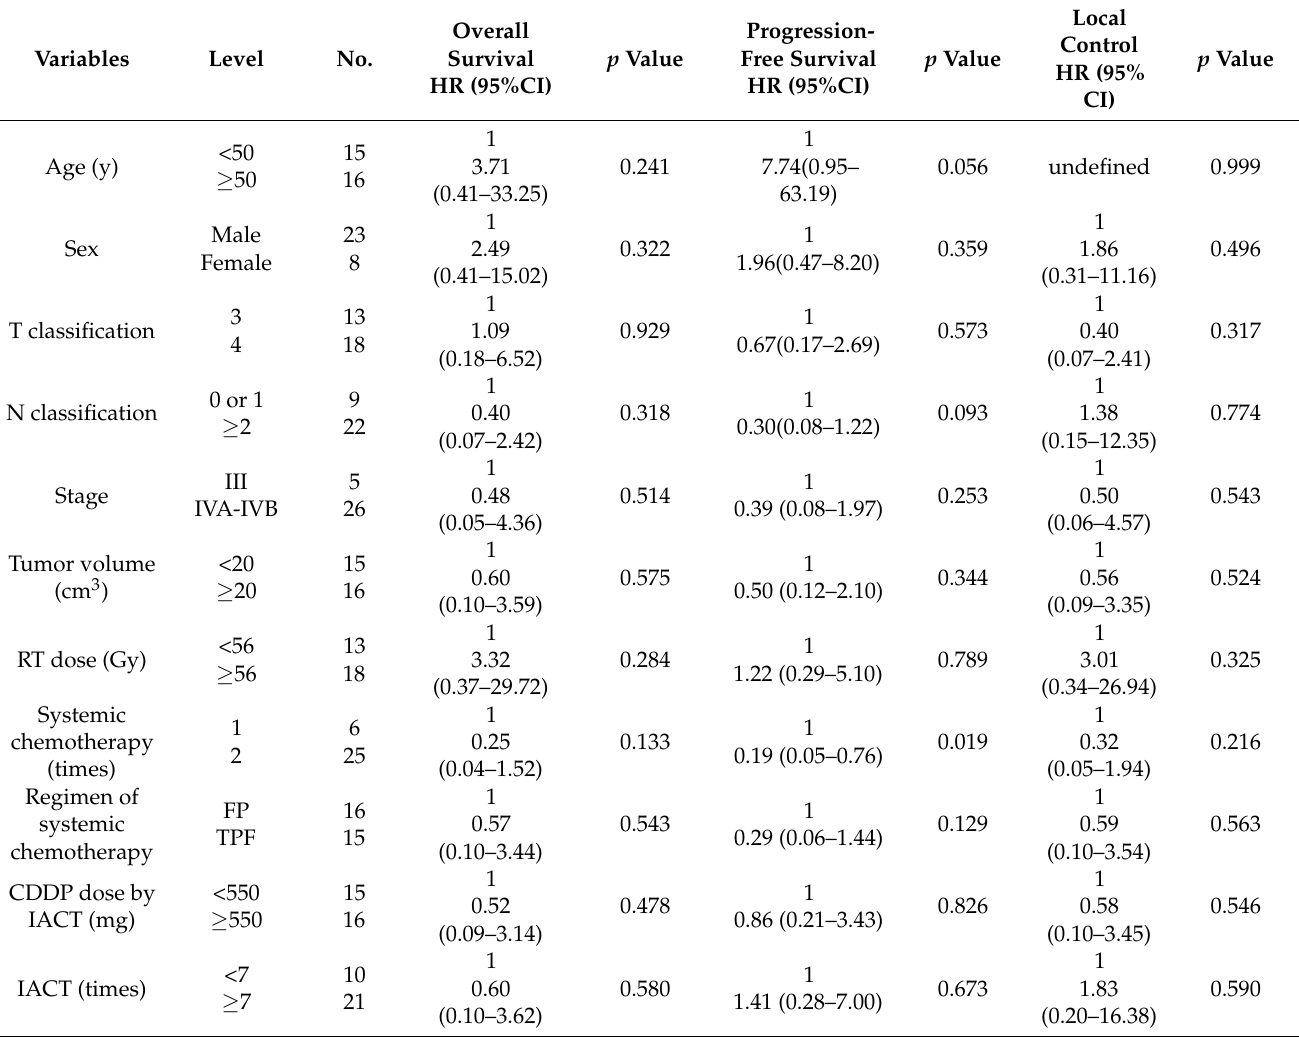
Table 3. Univariate analysis of patient’s characteristics and treatment factors.